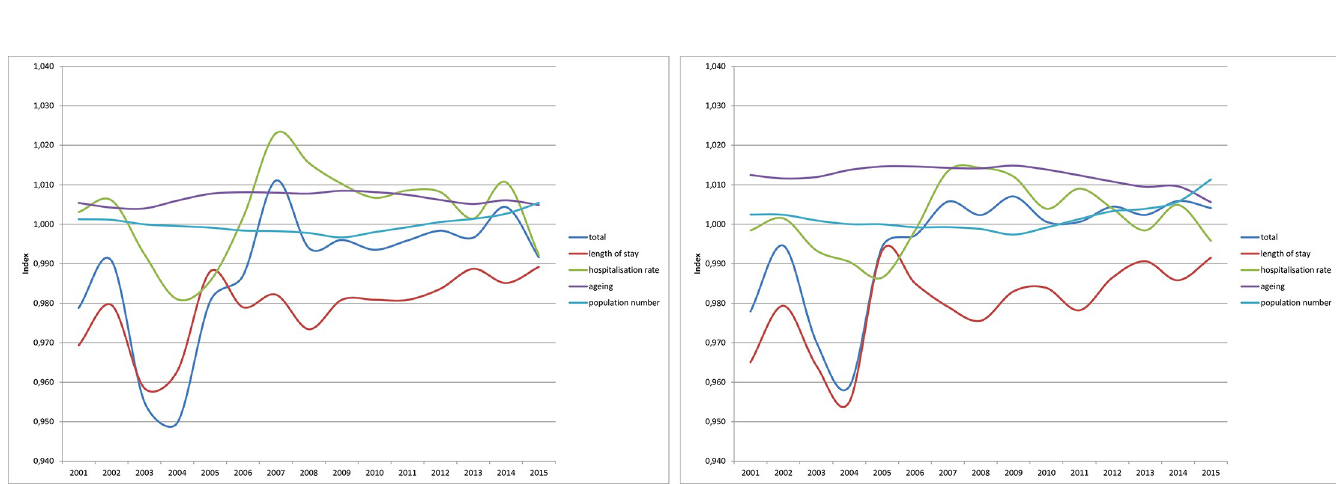
Fig 3. Decomposition of the hospital days 2000–2015: Development of the sub-indices (a) women and (b) men. Source: Hospital statistics 2000–2015 [19], population statistics [20], own calculations.